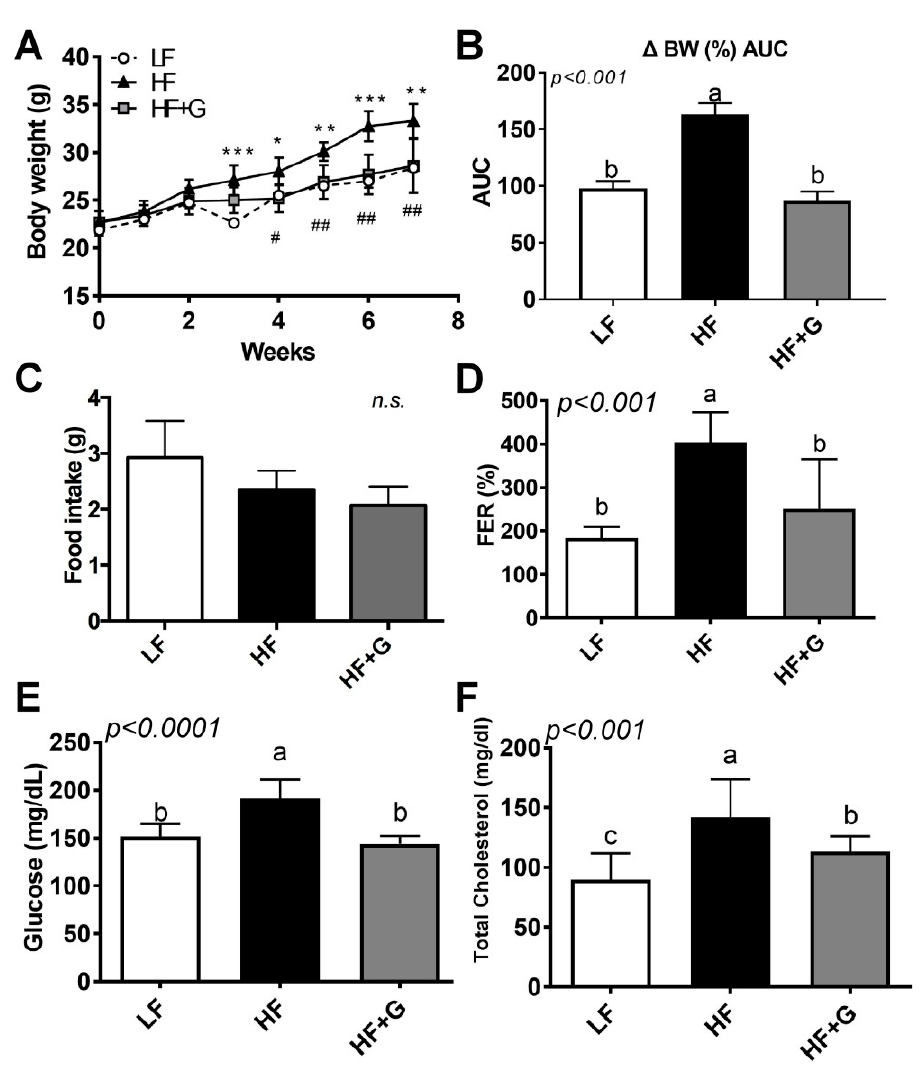
Figure 2. Ginger supplementation ameliorated HF-diet-induced metabolic parameters without a change in food intake. Male 6-week-old C57BL/6 mice were fed an LF (white circle, white bar), HF (black triangle, black bar), or HF + G (gray square, gray bar) diet for 7 weeks ( n = 4–5 per group). ( A ) body weight (g); ( B ) body weight (%) AUC (BW gain throughout the 7 weeks experiment expressed as % change from week 0 with AUC); ( C ) food intake (g/day); ( D ) feeding efficiency ratio (FER, %), calculated as body weight gain (g/day) divided by food intake (g/day); ( E ) fasting glucose levels (mg/dL); and ( F ) fasting serum total cholesterol levels (mg/dL). Data are expressed as the mean ± SEM ( n = 4–5). n.s. represents no significance. Bars with different letters are significantly different according to one-way ANOVA with Bonferroni’s comparison test; * p < 0.05, ** p < 0.01, *** p < 0.001 (LF vs. HF); # p < 0.05, ## p < 0.01 (HF vs. HF + G).